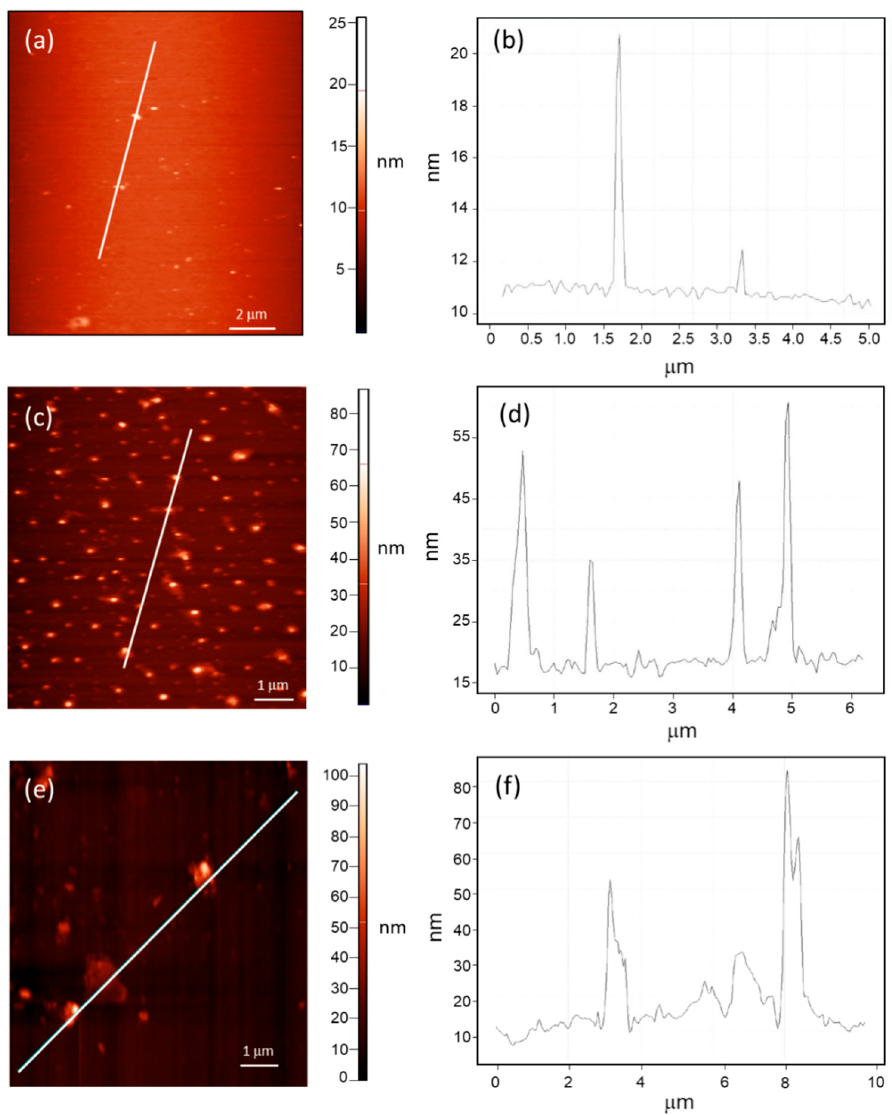
Figure 5. AFM topography image and height profile of the a-SiH NonIrr ( a , b ), a-SiH Irr ( c , d ), and the a-SiH Ann ( e , f ). 355